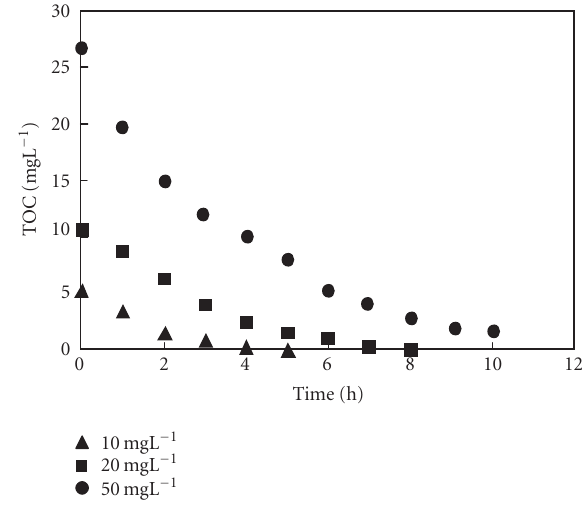
Figure 4: Variation of TOC during the photocatalytic degradation of aqueous solutions of